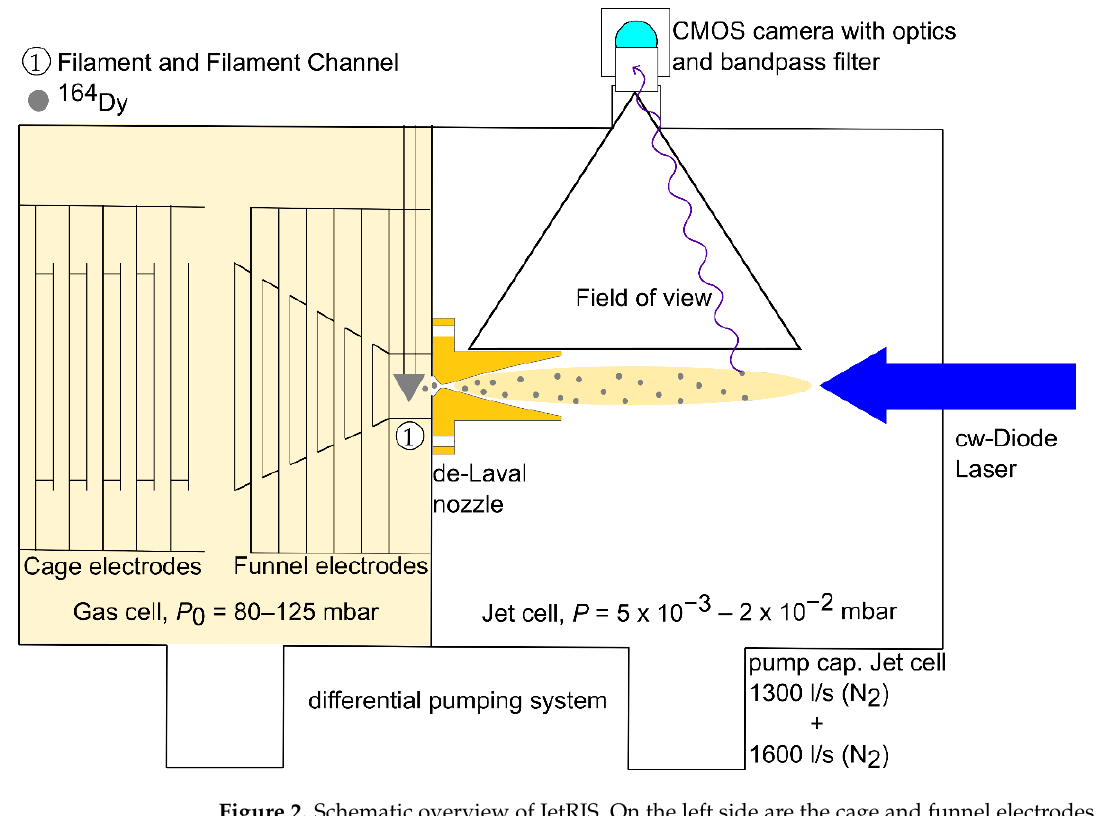
Figure 2. Schematic overview of JetRIS. On the left side are the cage and funnel electrodes, which are necessary for an online experiment but were not in use for the fluorescence measurements. In front of the nozzle, there is a tantalum filament that contains a piece of 164 Dy foil. After being evaporated from the filament, the atoms follow the flow of the buffer gas through the nozzle into the gas-jet. Here, a cw-diode laser beam at approximately 405 nm wavelength resonantly excites the dysprosium, and the resulting fluorescence is captured using a CMOS camera. The camera was mounted at a 45° angle relative to the field of view of this schematic.